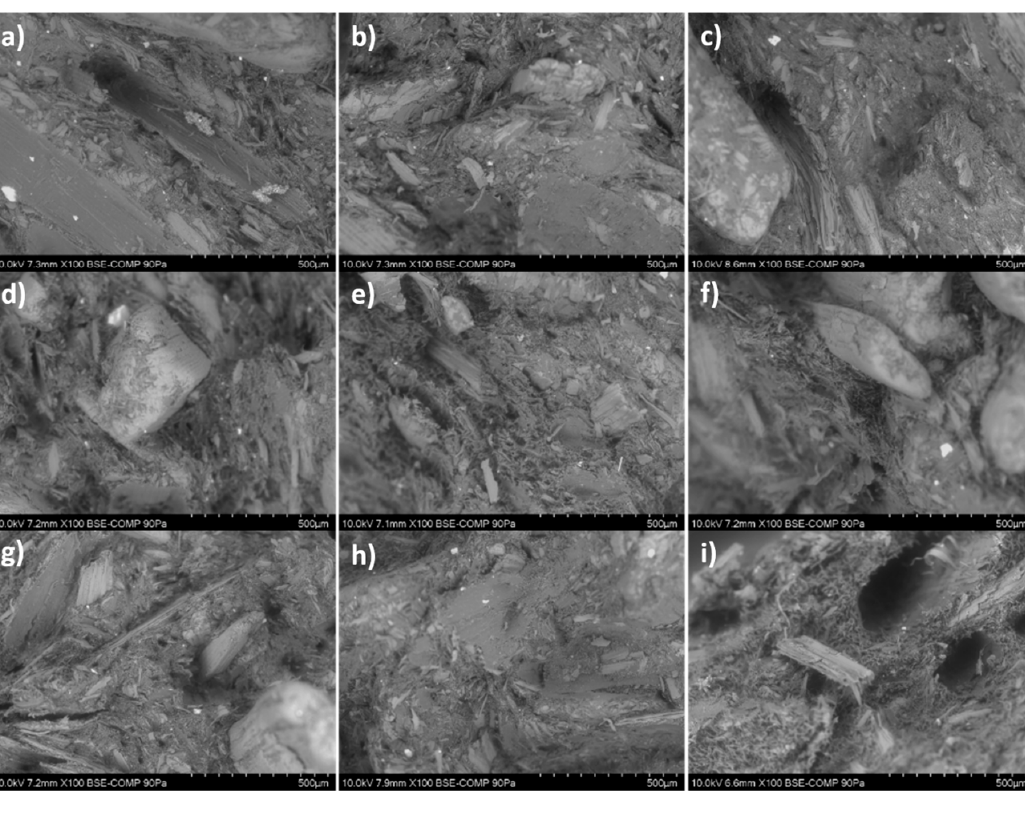
Figure 2. SEM images of the composites.